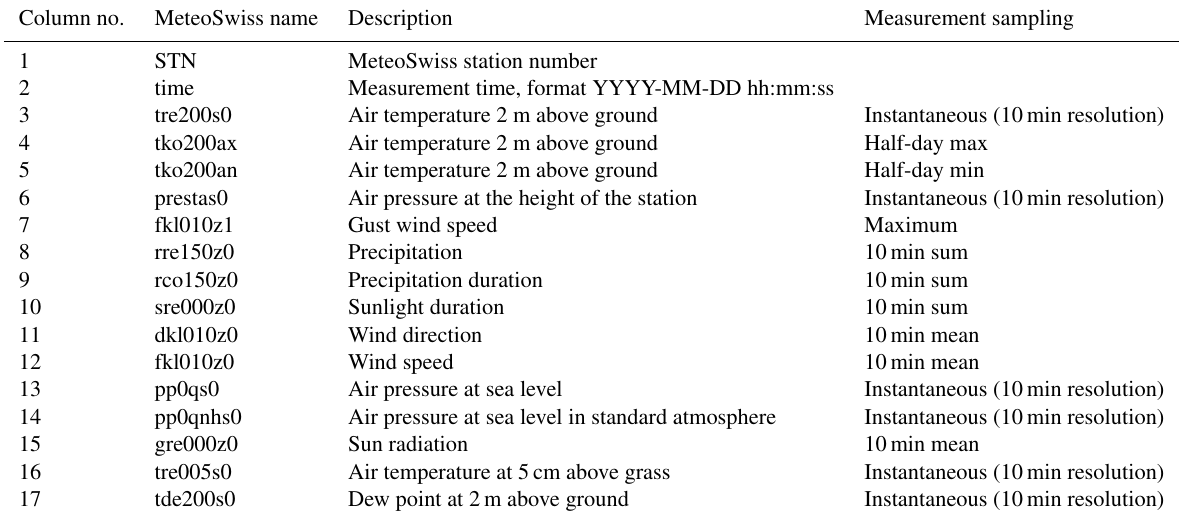
Table G1. MeteoSwiss weather station parameters.